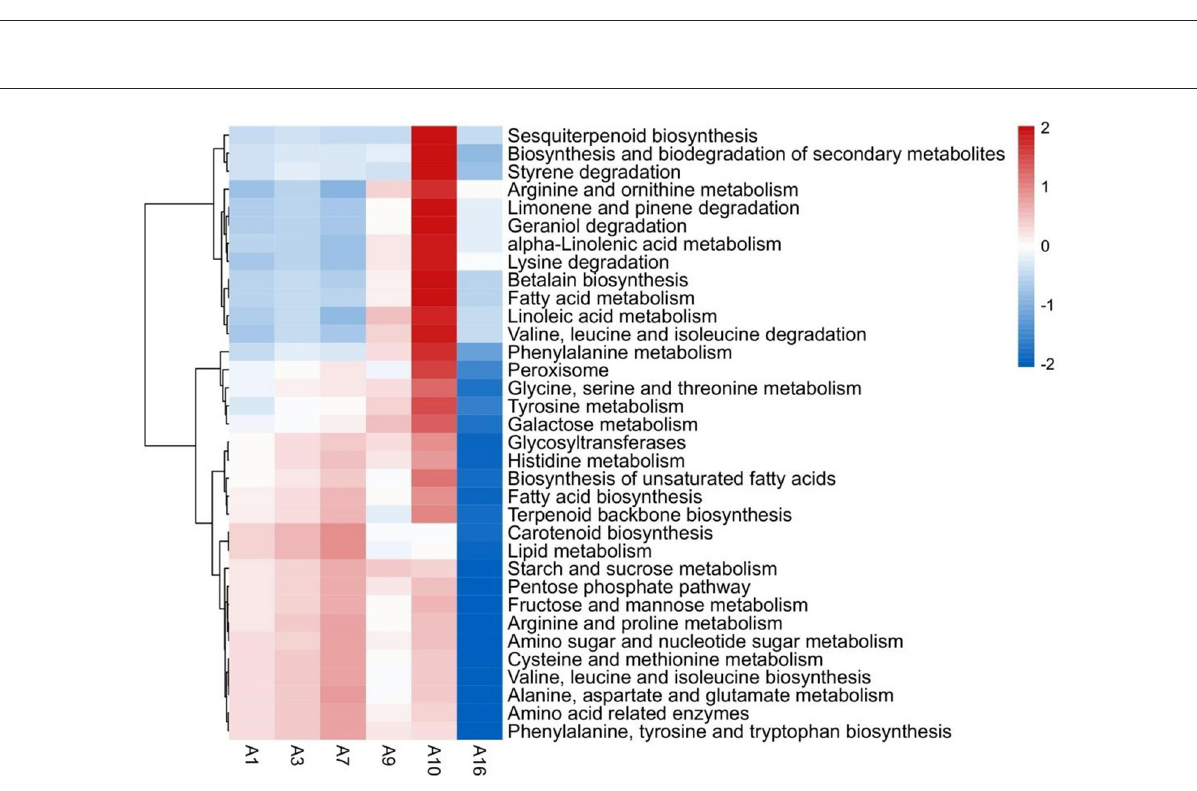
FIGURE7 Intensity thermogram of KEGG pathway related to bacterial involvement in VOCs metabolism. Red indicated high intensity, while blue indicated low